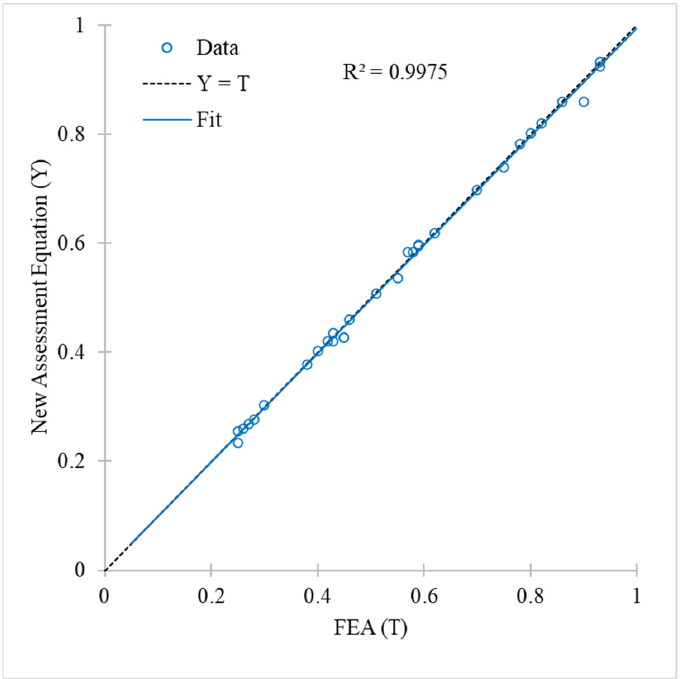
Figure 8. Regression plot of predicted normalised failure pressure by the assessment equations and FEA results for an unseen